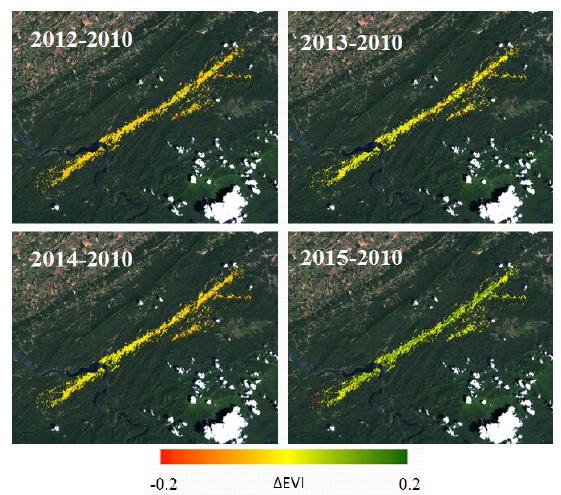
Figure 5: Anomalies of the Enhanced Vegetation Index for multiple years following the April 27, 2011 tornado. An example of changes in EVI during the recovery process can be seen for a selected area shown by Figure 6. The image on the left represents severity damage for area B from Figure 3. Points representative of high severity damage (red color) were averaged and used to generate a temporal profile of EVI. In 2010, EVI for the samples approached 0.457. A significant reduction in the index can be seen for 2011, corresponding to vegetation removal by the tornado. Following 2011, EVI